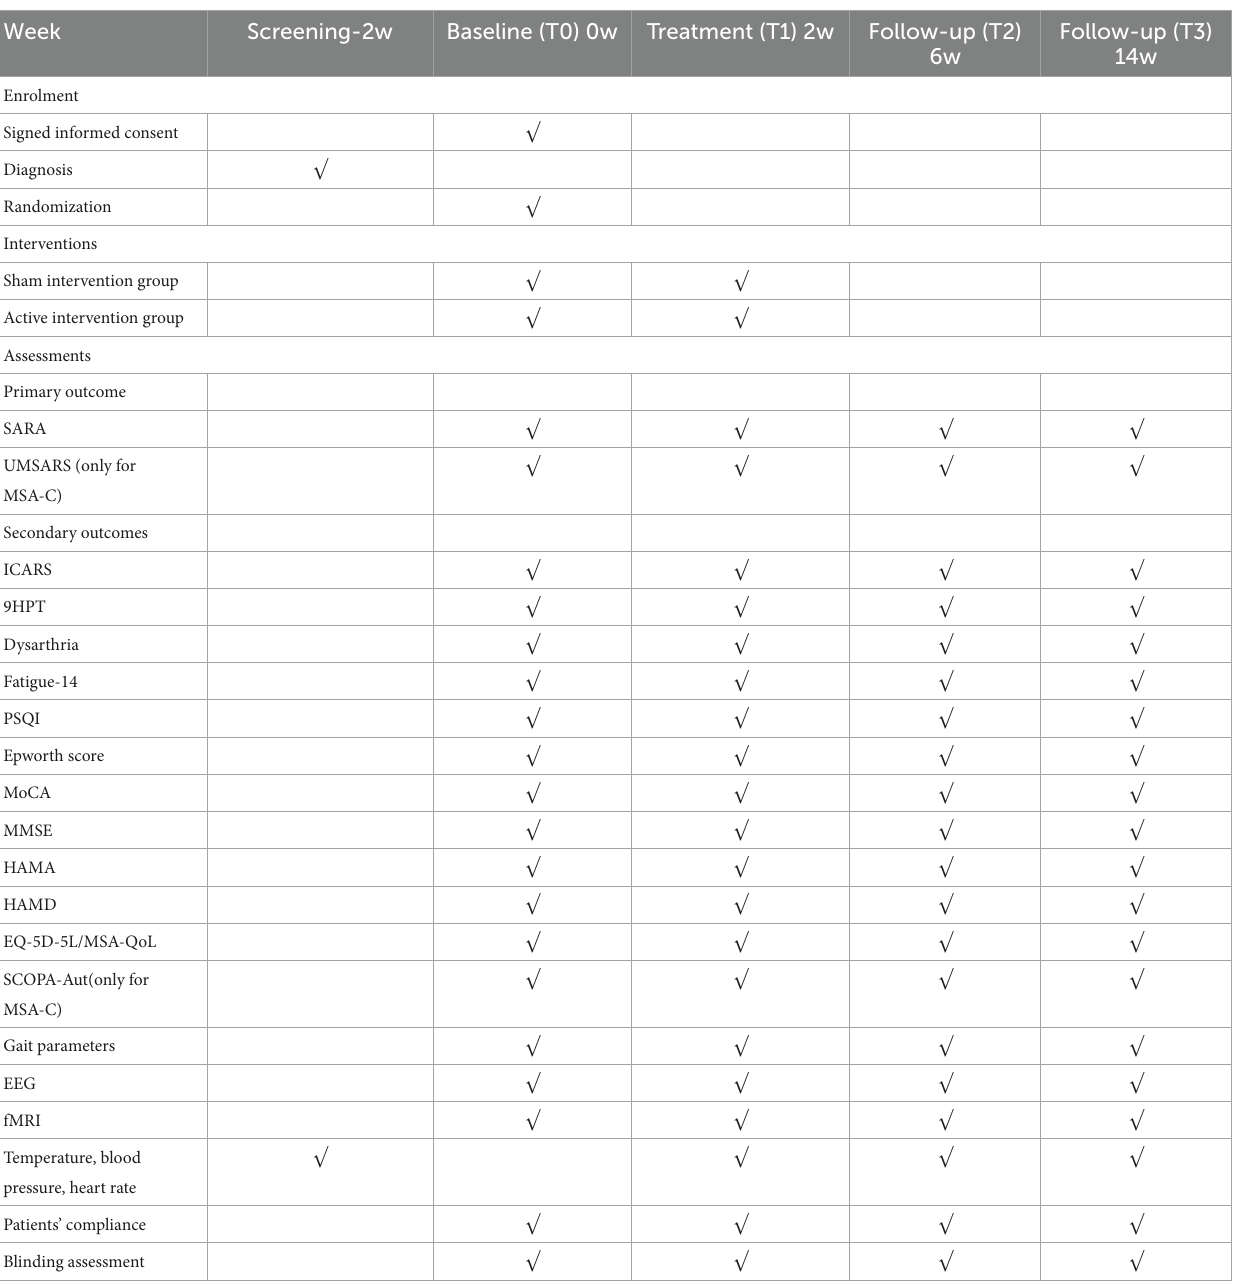
TABLE 1 Schedule of enrolment, interventions, and